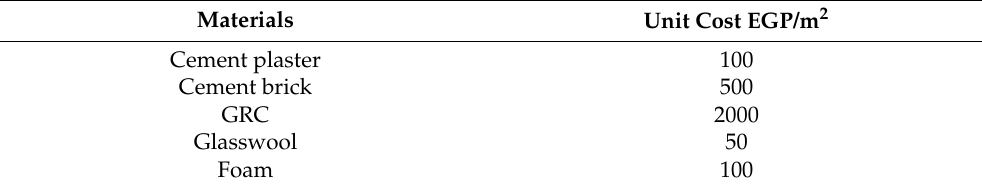
Table 3. The cost per unit of materials (source: Arab Contractor Company,